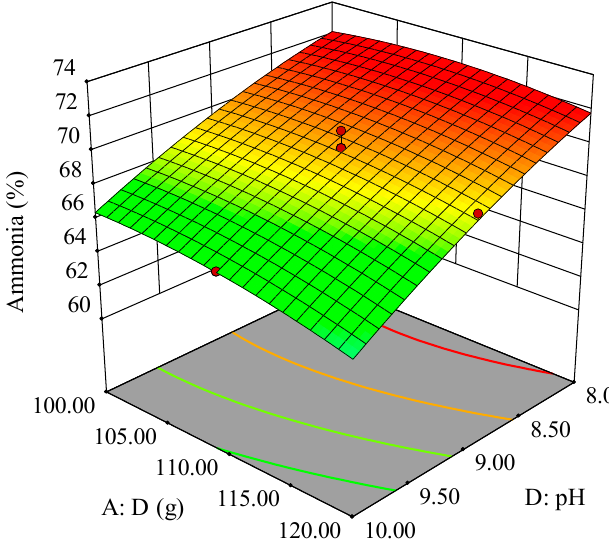
Figure 4. 3D surface plots for removal of ammonia on influences of dosage and pH. Water 2020 , 12 , x FOR PEER REVIEW